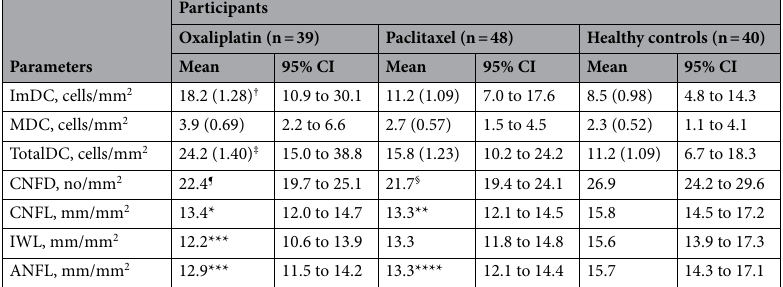
Table 2. Model based estimates from general linear model after adjusting for age, body mass index, gender and dry eye diagnosis for dendritic cell densities and corneal nerve parameters in participants. Data is presented as mean from model based estimates and log mean value in parentheses, with 95% confidence intervals (CI). Compared with healthy controls: † p = 0.03; ‡ p = 0.02; ¶ p = 0.01; § p = 0.005; *p = 0.004; **p = 0.006; ***p = 0.001; ****p = 0.008. ImDC immature dendritic cell density, MDC mature dendritic cell density, TotalDC total dendritic cell density, CNFD corneal nerve fiber density, CNFL corneal nerve fiber length, IWL inferior whorl length, ANFL average nerve fiber